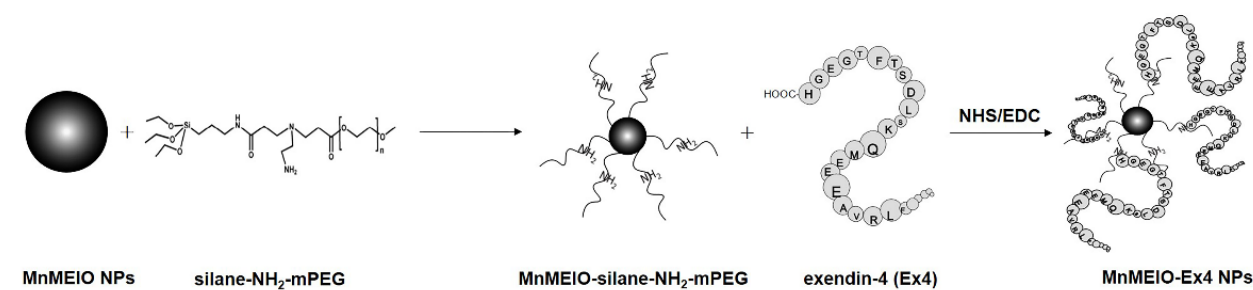
Figure 1. Schematic illustration of the synthesis of MnMEIO and MnMEIO ‐ Ex4 NPs.